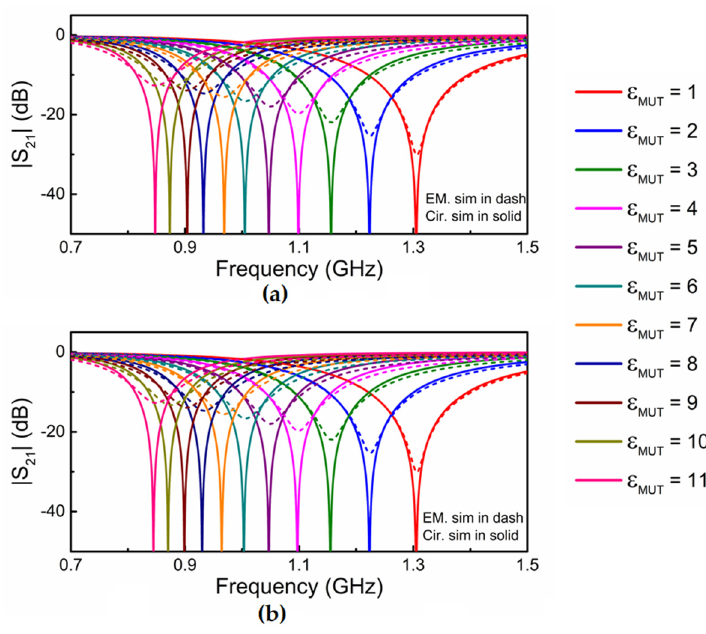
Figure 7. Responses (circuit and electromagnetic) of the DB-DGS-loaded microstrip line for various dielectric constants of the MUT. ( a ) Circuit responses obtained with C c inferred by curve fitting; ( b ) circuit responses obtained with C c calculated from (6).